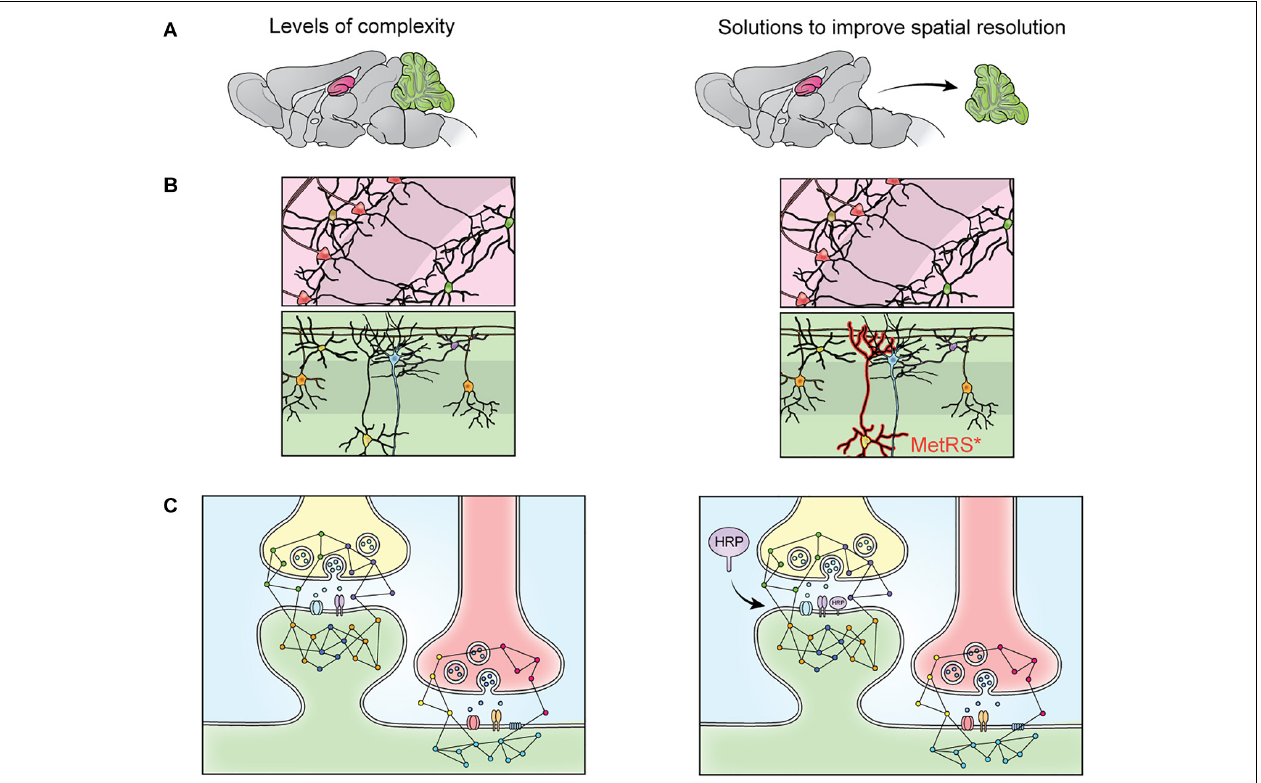
FIGURE 2 | The heterogeneity of the nervous system prevents isolation of specific proteomes though fractionation. The brain contains many substructures, such as the hippocampus (pink) and cerebellum (green) (A) . When the brain is homogenized, the proteomes of these structures are mixed and no longer distinguishable by MS. This limitation can be overcome via dissection (A) , but cellular heterogeneity remains (B) . When dissected brain areas are homogenized, the proteomes of specific cell types become indistinguishable via MS, this can be overcome by cell-specific tagging of proteins. For example, mutant methionine transferase (MetRS*) can be expressed in a cell specific manner to permit tagging and purification of proteins with a bio-orthogonal amino acid (B) . Cells of the nervous system are also highly compartmentalized. Specific cellular compartments, such as the synaptosome, can be isolated via fractionation, but isolation of specific synapse types is not possible with fractionation (C) . This can be addressed by targeting a protein labeling enzyme (here, HRP) to a specific subcellular locale, where it will label only nearby proteins (C)